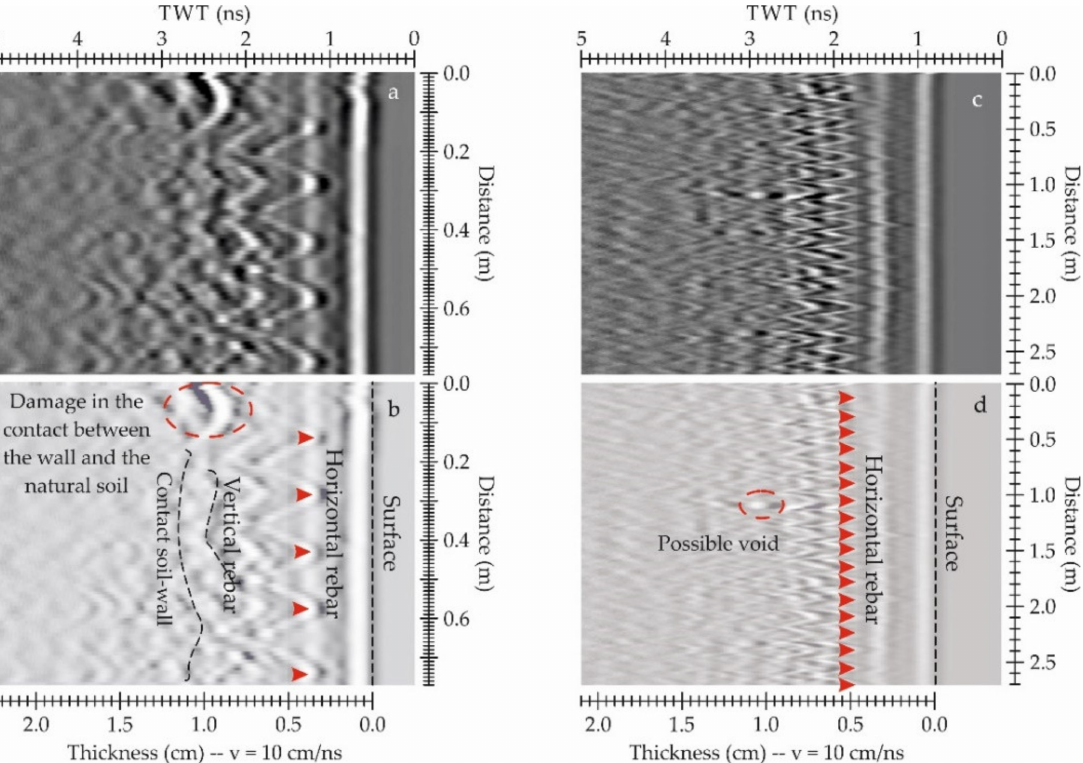
Figure 5. Two examples of GPR images ( a and c ) obtained in reinforced retaining wall assessments with a 2.3 GHz antenna. Both cases focus on the detection of the rebar and the location of zones with possible damage ( b and d ).